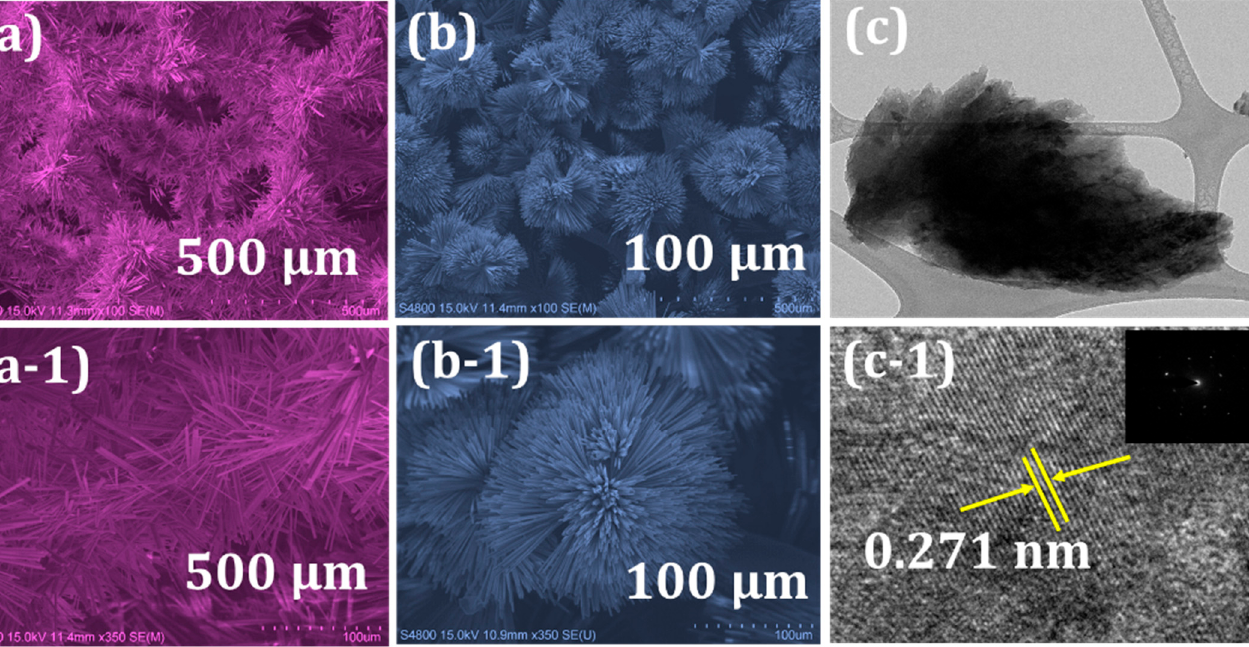
Figure 1. [( a , a ‐ 1 , b , b ‐ 1 )] False FE ‐ SEM images of NiCl 2 obtained with and without glycerol at differ ‐ ent magnifications, and ( c ) TEM image; ( c ‐ 1 ) HR ‐ TEM (inset shows SEAD pattern) of NiCl 2